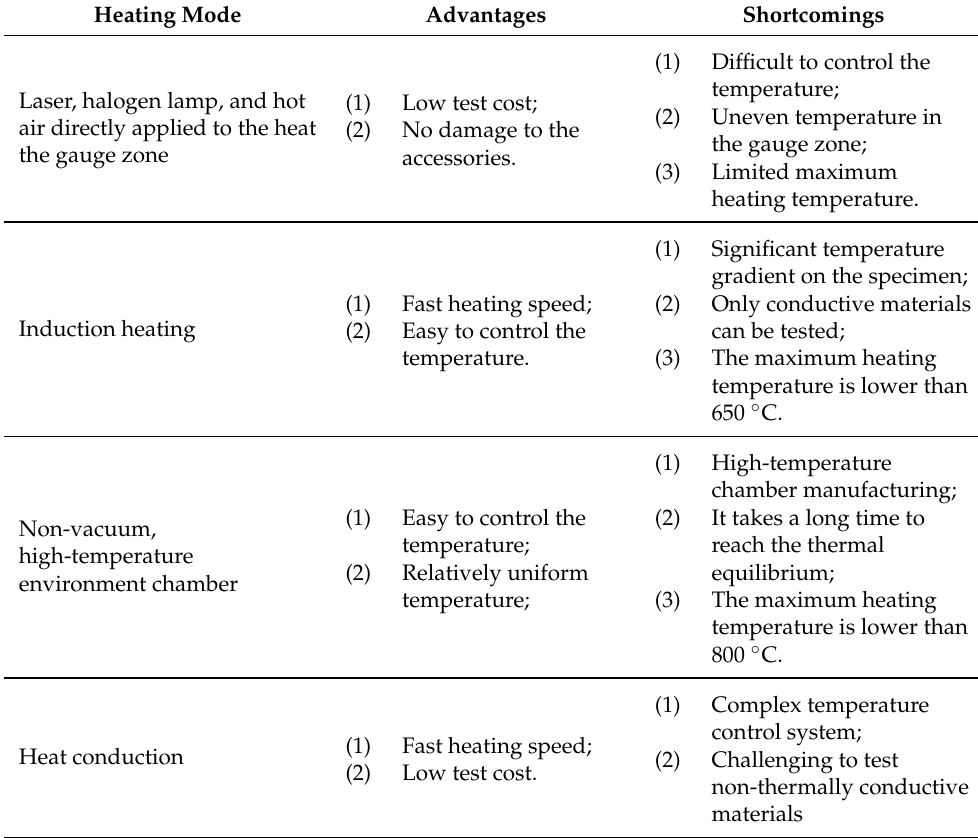
Table 3. Advantages and disadvantages of different heating